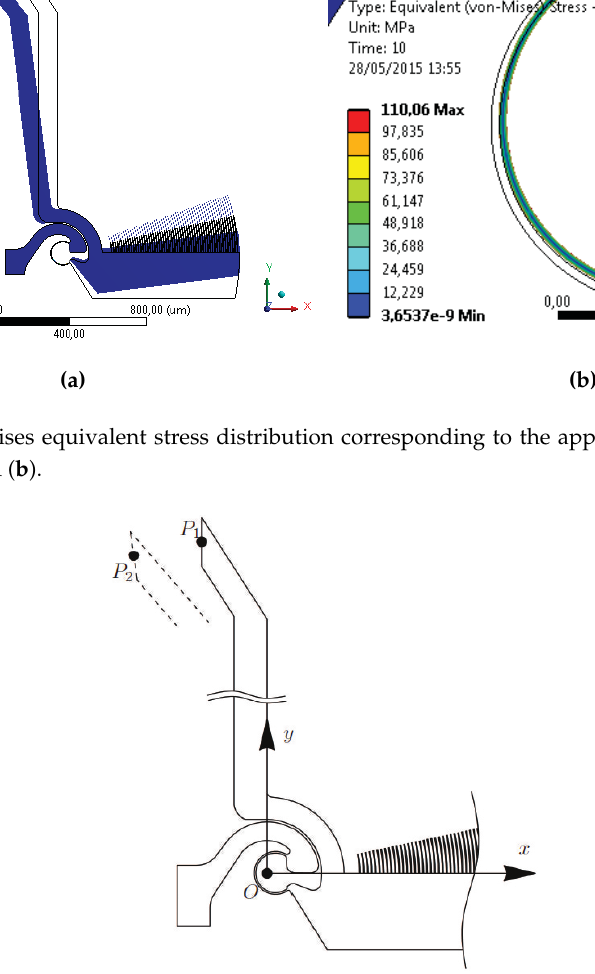
Figure 4. Determination of the center of rotation: reference frame and nomenclature.